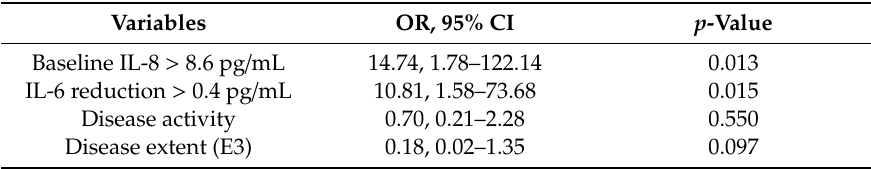
Table 4. Adjusted OR of variables included in the multivariate regression analysis for the prediction of clinical response at T2 in patients with